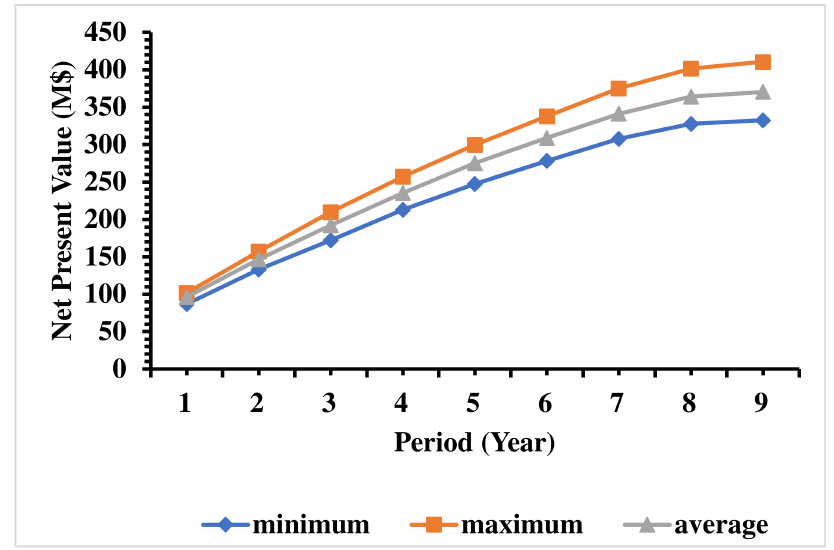
Figure 5. Cumulative discounted cash flow of the study mine using the proposed